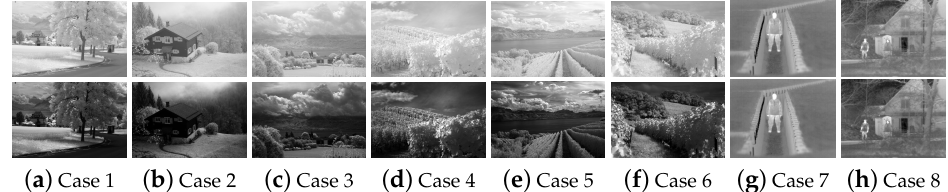
Figure 2. Comparison of dynamic range of the IR images and the stretched IR images. ( a – f ) are the scenes which contain more trees and plants. ( g , h ) are the other